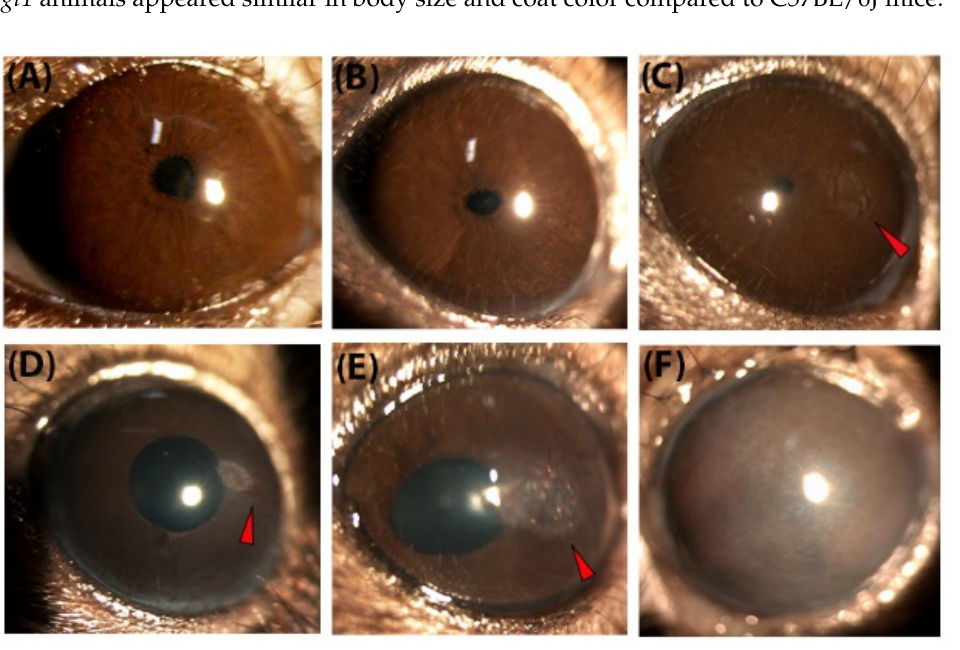
Figure 1. Anterior segment morphology in egl1 mice. ( A – I ) Representative slit lamp image from C57BL/6J ( A ) and egl1 mice ( B – I ). ( A ) Representative slit lamp image showing clear and avascular cornea and centrally located pupil in uniformly shaped iris. ( B ) Normal cornea from an egl1 mouse. ( C – I ) Anterior segment lesions in egl1 mice. The egl1 mice developed a variety of anterior segment lesions (indicated by triangles) such as localized faint opacity in paracentral zone of the cornea ( C ), dense corneal opacity with neovascularization ( D , E ), iris thinning ( D , E ) and pupil deviation ( E ), diffuse opacity covering the entire cornea ( F ), and iris synechiae (the iris adhesion to the cornea) ( G – I ). ( H ) Enlarged view of area indicated by arrow in ( G ). ( J – L ) Representative H&E staining im- ages of cross-section of the ciliary body and iridocorneal angle from C57BL/6J ( J ), egl1 mouse with normal IOP ( K ) and after 4 weeks of IOP elevation ( L ). The iridocorneal angle remained open and ciliary body appeared normal triangular in C57BL/6J and the egl1 mice with normal IOP. Anterior synechiae (the iris attached in the iridocorneal angle) and ciliary body atrophy were seen in eyes with elevated IOP. Scale bar = 50 µm. 3.2. IOP Elevation in egl1 Mice The egl1 mice were maintained on the C57BL/6J background; thus, C57BL/6J mice were used as control animals in this analysis. We monitored the conscious IOP longitudi- nally in a cohort of 22 egl1 mice and 6 C57BL/6J mice using the TonoLab tonometer (Figure 2A–C). At 3 weeks of age, egl1 mice exhibited an IOP of 15.9 ± 0.5 mmHg (mean ± SEM; n = 44) which was similar to age-matched C57BL/6J control mice (14.0 ± 1.3 mmHg; mean ± SEM; n = 12). A significant elevation of IOP was observed in egl1 mice as early as 4 weeks old and remain elevated at all ages examined. The IOP values were 19.2 ± 0.6, 21.7 ± 0.8,